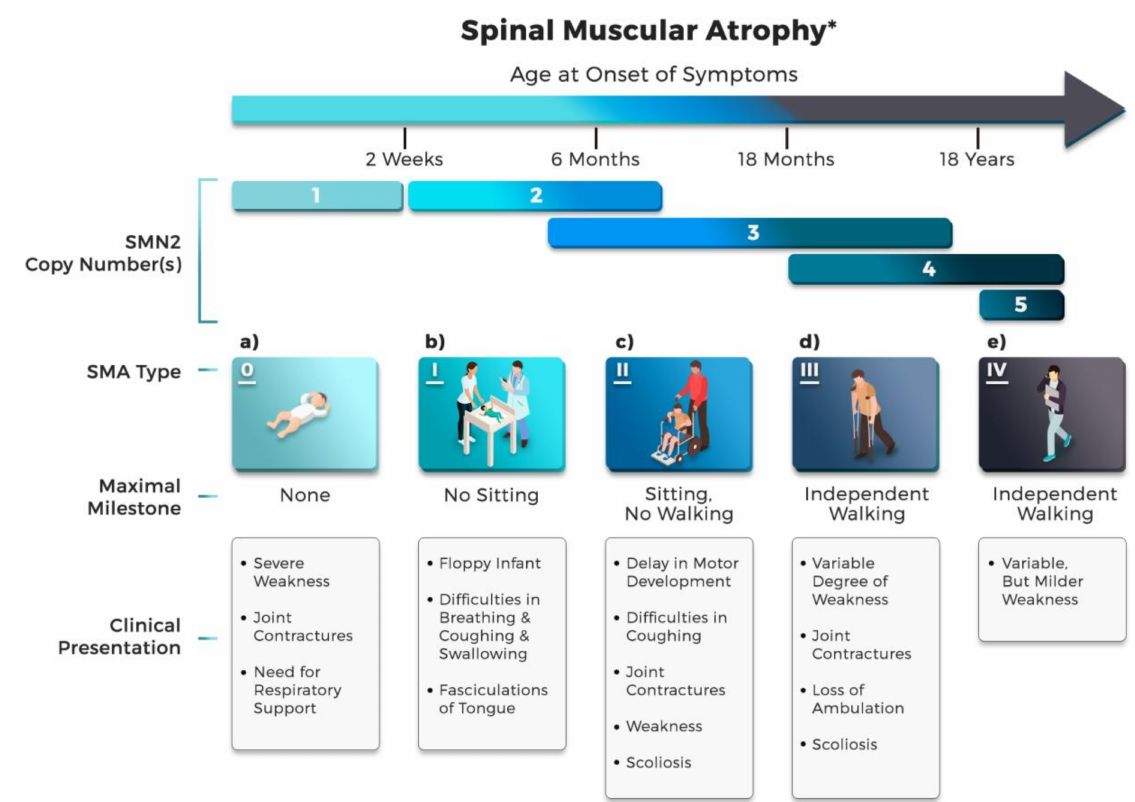
Figure 3. Classification of spinal muscular atrophy (SMA) sub-types. * All SMA patients, regardless of the subtypes, have no functional copies of survival motor neuron 1 ( SMN1 ). SMA can be classified into five types (0-IV) ranging from the most severe form to a milder form. ( a ) Type 0 is the most severe form and in-utero onset. They normally have limited life expectancy. ( b ) Type I infants display clinical symptoms at birth or by the age of six months. They never develop the ability to sit and if no intervention is provided results in death by two years. ( c ) Type II patients are diagnosed within six to 18 months of age and they do develop the ability to sit but they never walk unaided. However, they are able to survive well into adulthood. ( d ) Type III can be further classified into IIIa (onset between 18 months to three years old) and IIIb (onset between ages of three to 30 years old). They have a normal life expectancy. ( e ) Type IV is the mildest form and adult-onset. Patients with type IV have a normal life